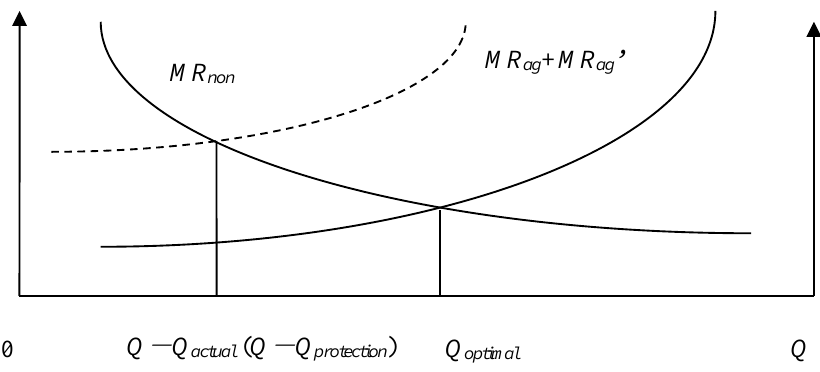
Figure 5. Allocation of county-level land resources under the fifth situation.